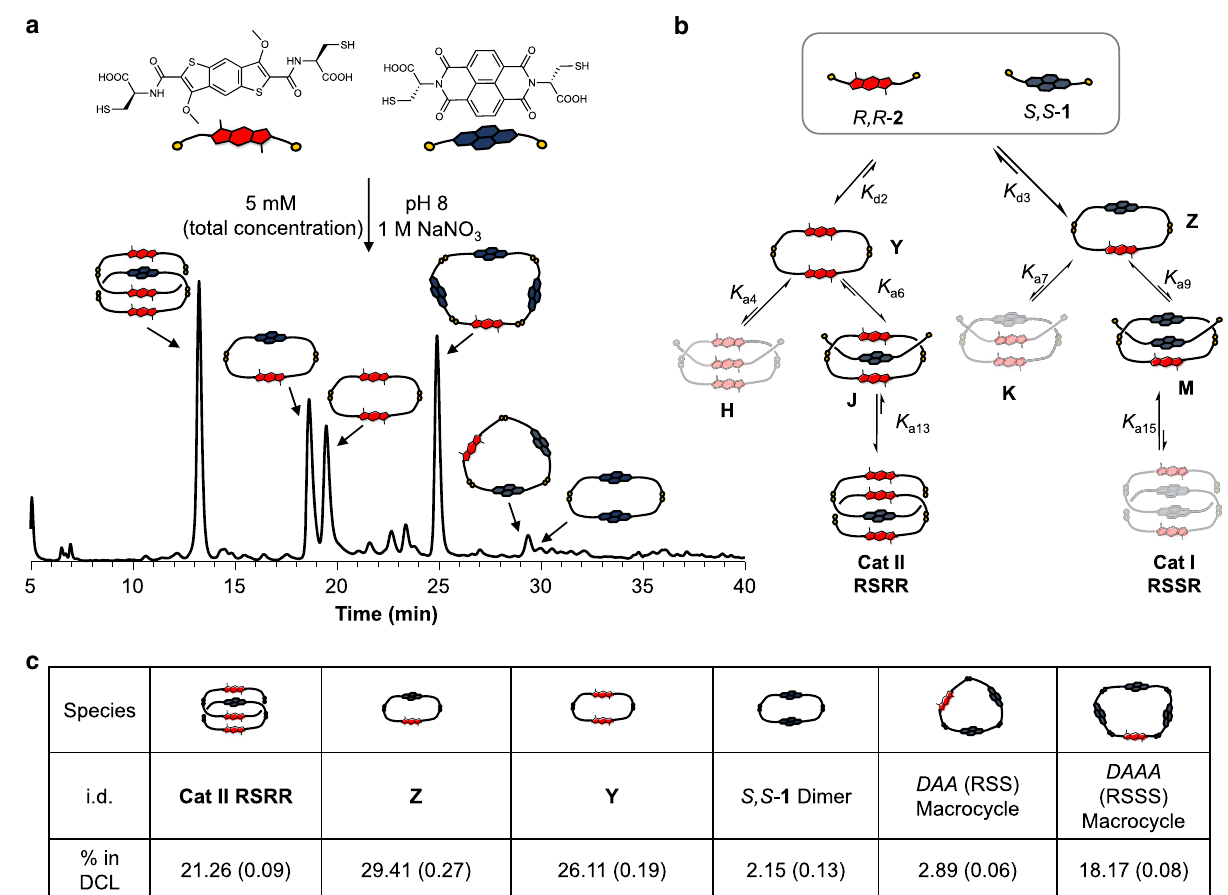
Fig. 3 Heterochiral DCL. a Reverse-phase HPLC analysis at 389 nm of S,S - 1 : R,R - 2 (1:1 molar ratio, 5 mM total concentration) library in the presence of 1 M NaNO 3 ; b schematic representation of equilibria showing the pathway for the formation of Cat II RSRR and c table containing the yield for each species in DCL; the integrations were done in triplicate and the RMSD is reported in parenthesis along with the